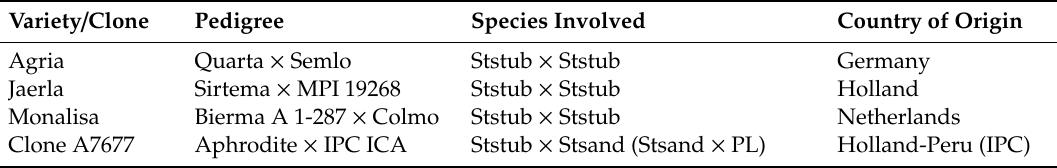
Table 2. Species involved and country of origin of four potato tetraploid parents (2n = 4x = 48). Variety / Clone Pedigree Species Involved Country of Origin Agria Quarta × Semlo Ststub × Ststub Germany Jaerla Sirtema × MPI 19268 Ststub × Ststub Holland Monalisa Bierma A 1-287 × Colmo Ststub × Ststub Netherlands Clone A7677 Aphrodite × IPC ICA Ststub × Stsand (Stsand × PL) Holland-Peru